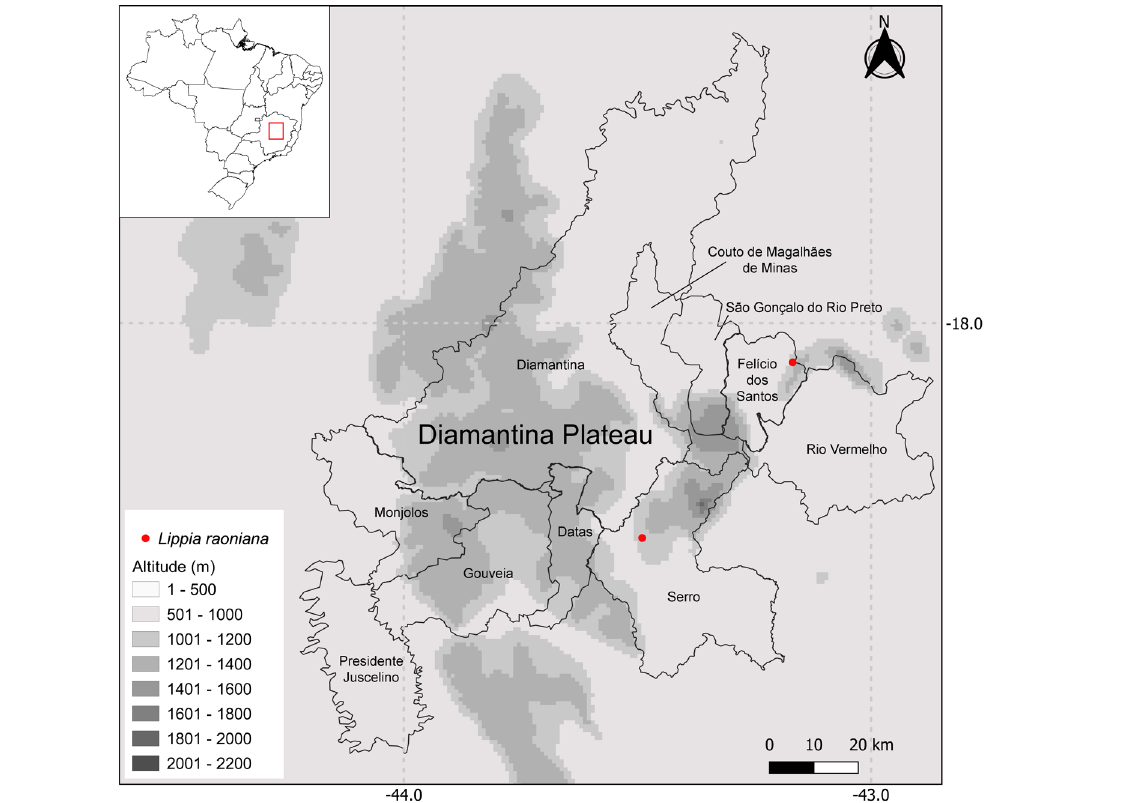
Fig. 2. Map of the Diamantina Plateau, Minas Gerais, Brazil, showing the known distribution of Lippia raoniana P.H.Cardoso & Salimena sp.